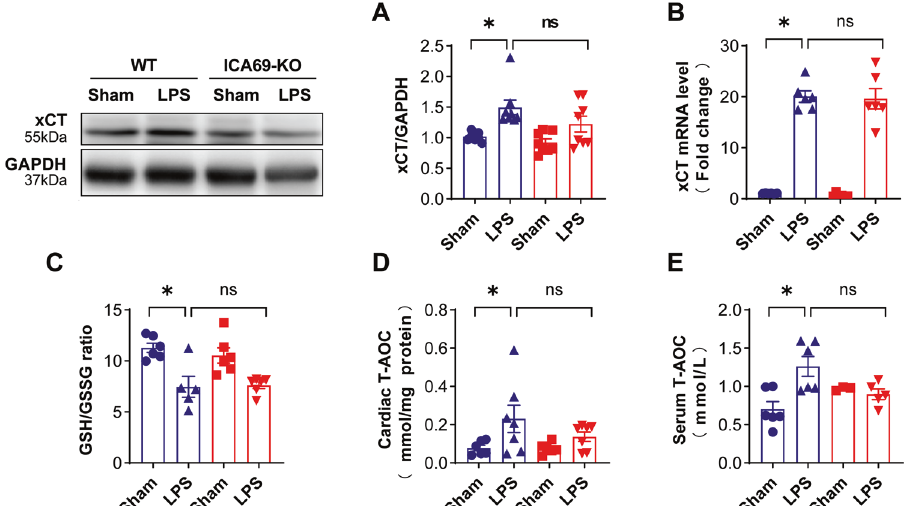
Fig. 6 xCT and GSH/GSGG levels in ICA69 de fi ciency mice during sepsis. A Representative immunoblots and densitometric analysis of total xCT in cardiac tissue of ICA69-de fi cient (KO) and wild-type (WT) mice after LPS challenge. Levels of total xCT intensity were normalized to the corresponding GAPDH level, and the changes are shown in the histograms ( n = 8). B The mRNA levels of xCT in the indicated groups that were stimulated with LPS or PBS for 12 h ( n = 6). C GSH/GSSG ratio of ICA69-KO and WT mice after LPS injection ( n = 6). D , E The level of T-AOC in the indicated groups in cardiac tissue and serum ( n = 7/6). The data are expressed as the mean ± standard error of the mean. * P < 0.05 vs. WT + LPS group, ns no signi fi cance.